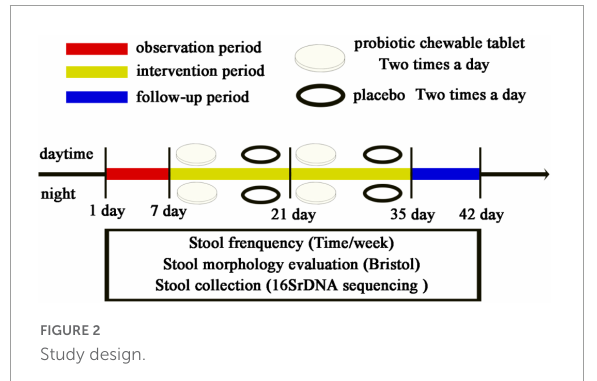
FIGURE2 Study design.